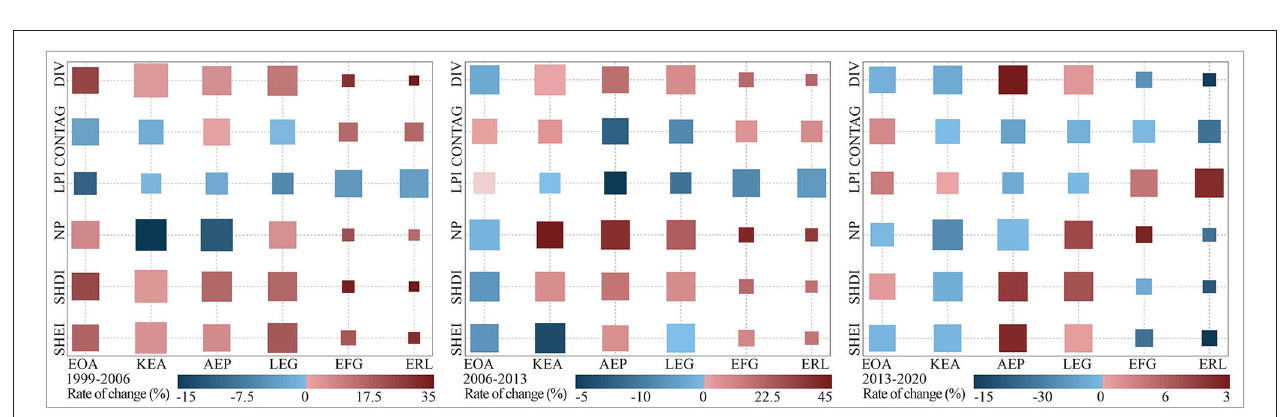
FIGURE 6 | Heat maps of landscape metrics changes in each environment functional region from 1999 to 2006, 2006 to 2013, and 2013 to 2020; the square sizes in the figure are the normalized values of landscape metrics of each environmental function zone in 1999, 2006, and 2013; The color in the figure is the rate of change of landscape metrics. The value of change refers to the average of the landscape pattern metrics of each environmental functional region.